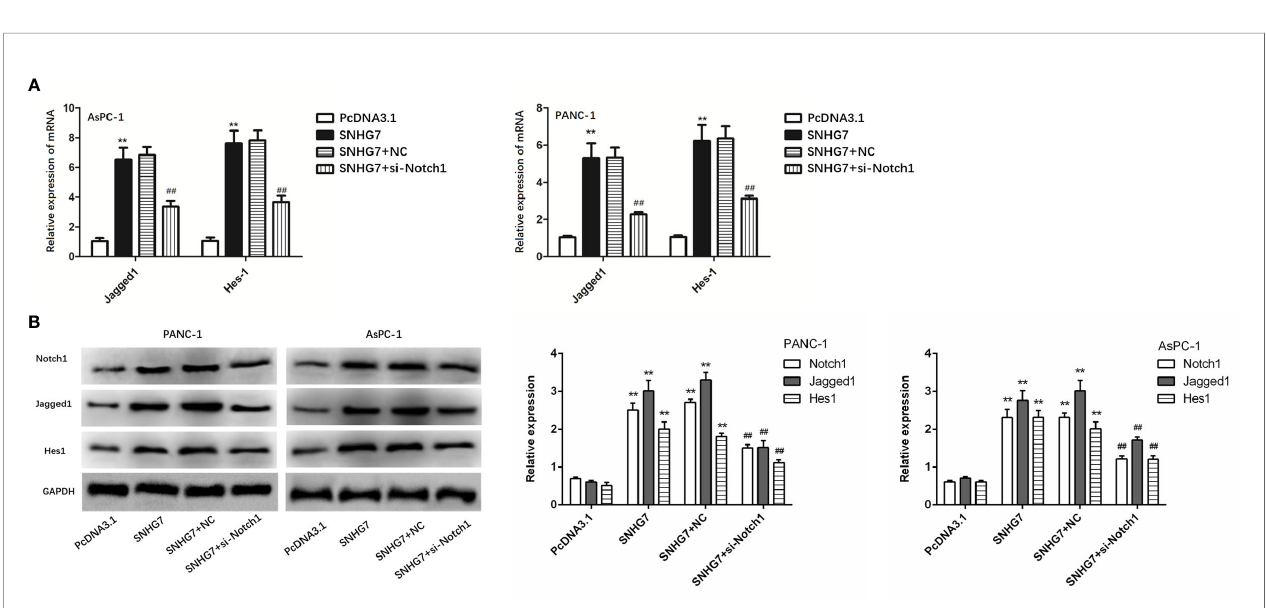
FIGURE 6 | Notch1 to regulate the stemness and Fol fi rinox resistance in pancreatic cancer. (A) Notch1 expression was assessed via RT-qPCR assay. (B) The expression of stemness markers were analyzed by using Western blot assay. (C – E) Sphere-formation assay, Colony-formation, and fl ow cytometry analyses. **P < 0.01 (compared with pcDNA3.1), ## P < 0.01 (compared SNHG7+NC with SNHG7+si-Notch1).